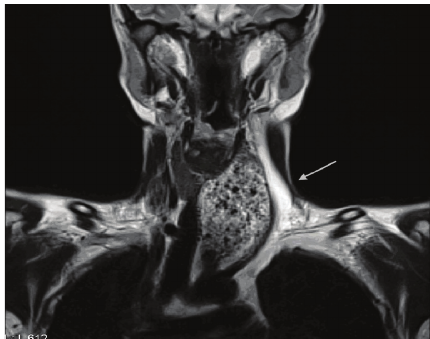
F 1: MRI scan of the neck region demonstrating a le palpable neck mass (arrow) with the presence of food remnants in the esophagus and displacement of the trachea to the right (coronal view).